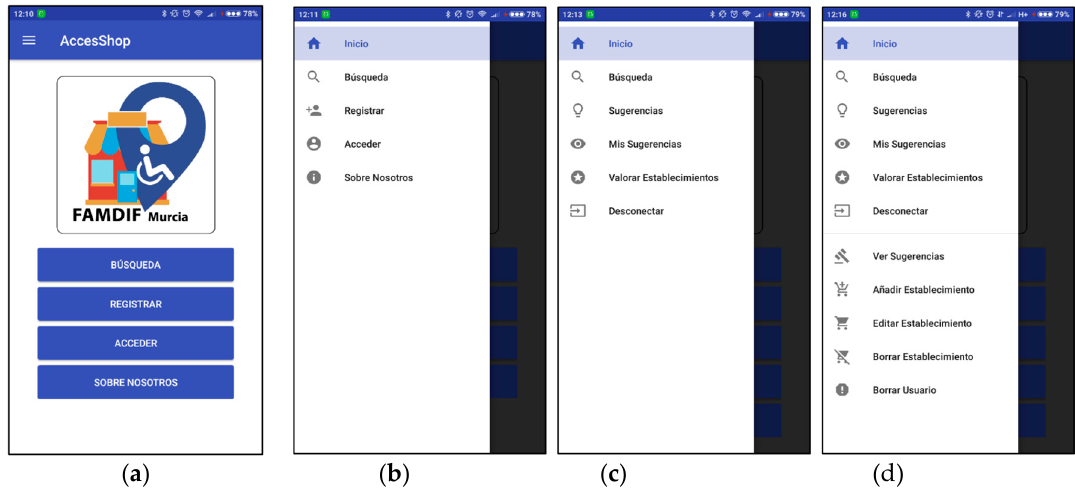
Figure 6. Different views of the app. ( a ) Initial screen. ( b ) Menu options for unregistered user. ( c ) Menu options for registered user. ( d ) Menu options for administrator user.